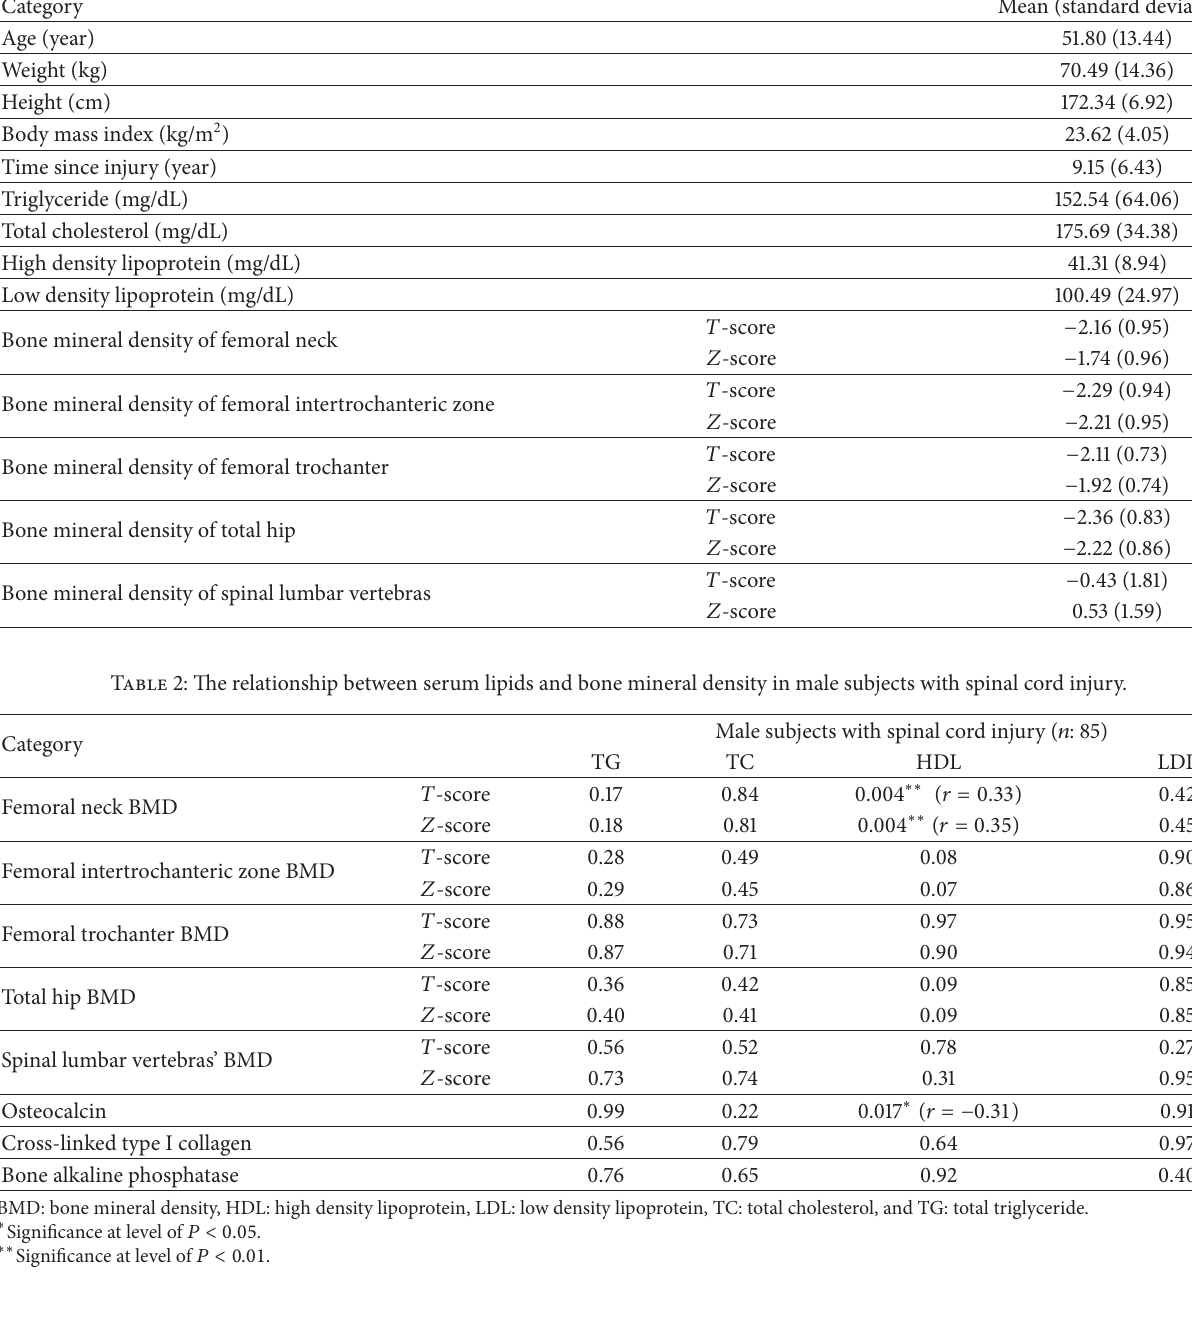
Table 1: Baseline characteristics of study cases and differences of basic features among male subjects with spinal cord injury ( 𝑛 : 85). Category